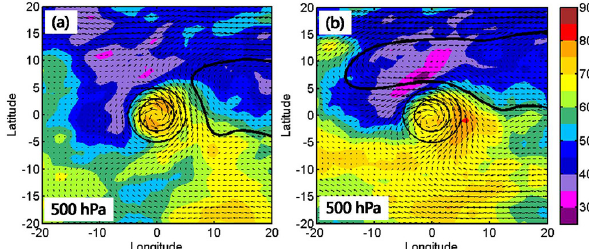
Figure 6. As in Fig. 4 but at time t + 24h .